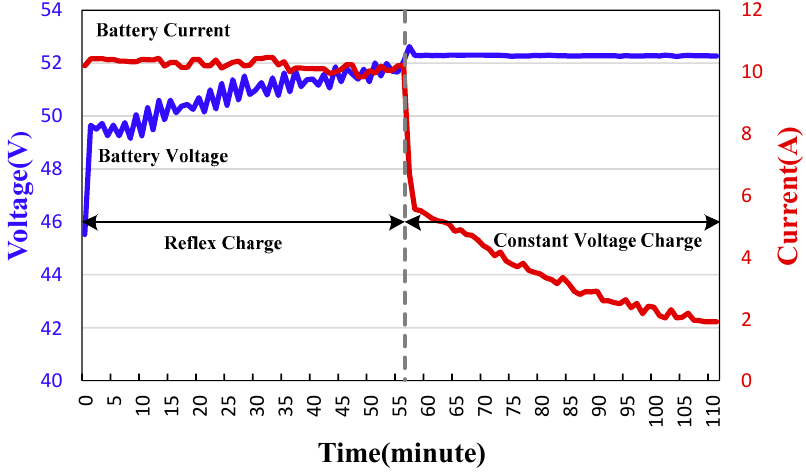
Figure 11. The complete voltage/current charging profile of the proposed high-gain RC-BDC.